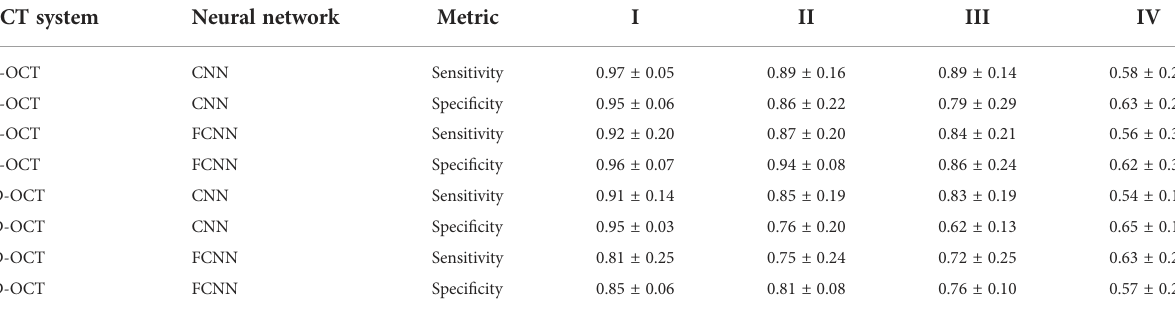
TABLE 3 Sensitivity and speci fi city for the different classi fi cation tasks, determined on the k-fold cross-validated test data from the SS-OCT and SD-OCT dataset and for both used neural network (CNN/FCNN). OCT